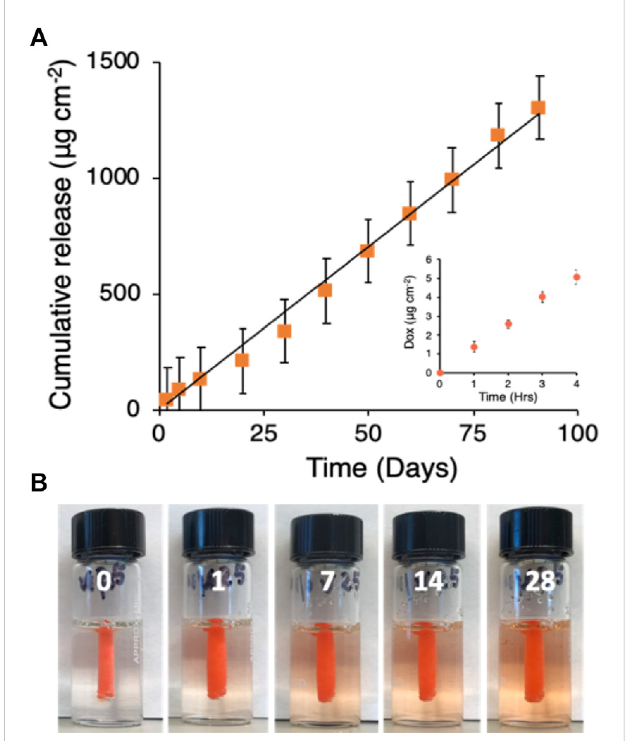
FIGURE 7 (A) Doxorubicin release kinetics. Black line is the linear fi t to the mean data points (n = 3, R 2 = .99). Inset: fi rst 4 h of release. (B) Visualization of DOX release from solid GPX into a gelatin tissue phantom over 28